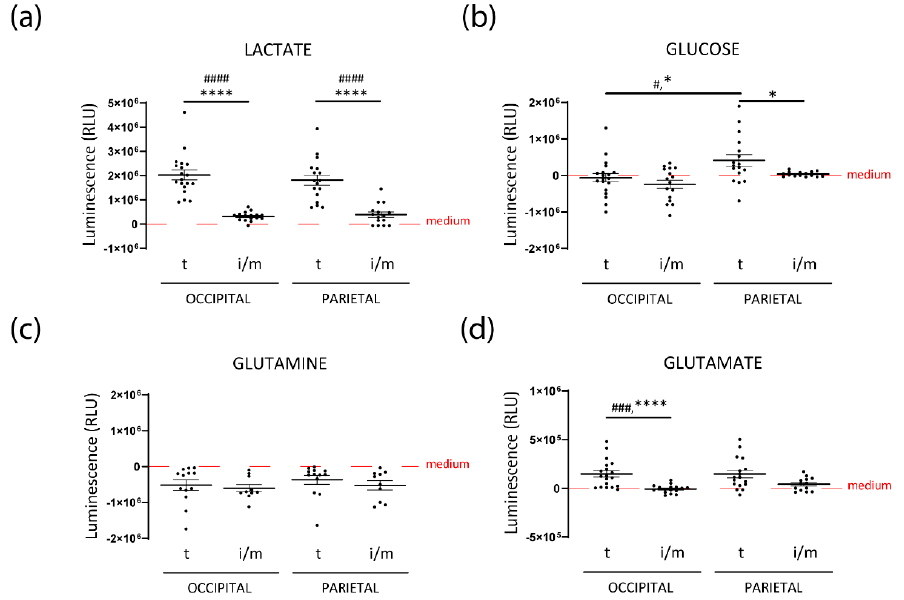
Figure 3. Intermediate FPHL HFs reveal lower metabolic activity ex vivo. ( a ) Lactate, ( b ) glucose, ( c ) glutamine, and ( d ) glutamate concentration was measured in the WCM culture medium after 24 h HF culture following recommended protocols for Glo™ Assays kits (Promega ® , Wall- dorf, Germany). Mean ± SEM recorded luminescence from n = 9 − 19 HFs/ group from n = 3 − 4 FPHL donors. Red dotted lines indicate the amount in the blank, non-conditioned, WCM culture medium. GraphPad Prism 9.0; Kruskal–Wallis test and Dunn’s multiple comparison test # p < 0.05, ### p < 0.001, #### p < 0.00001; Multiple Mann–Whitney test (Benjamini and Hochberg 5%FDR cor- rection), * p < 0.05, **** p < 0.00001. t: terminal; i/m: